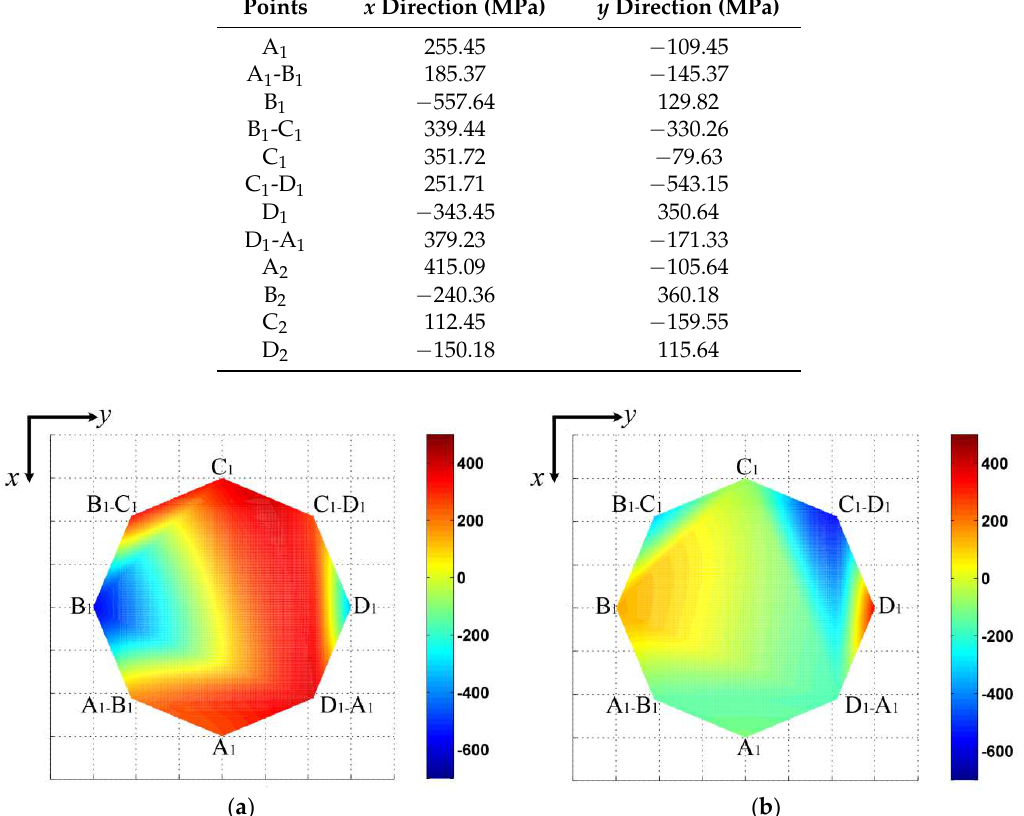
Figure 6. Residual stress distribution in x and y directions of specimen 2# (pit 1): ( a ) x direction; and ( b ) y direction. ( b ) y